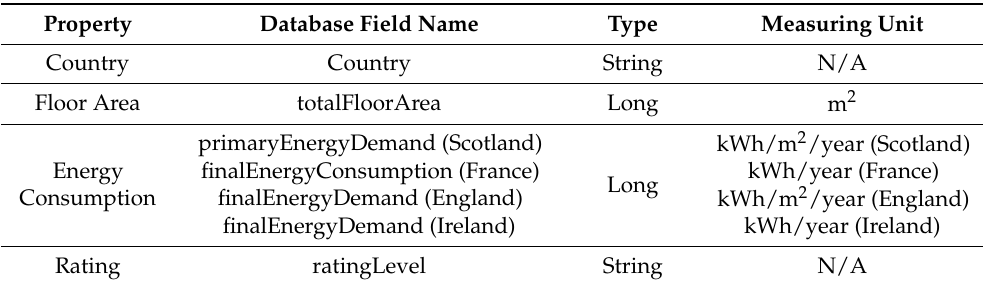
Table 4. Dwelling properties used for estimating the energy performance